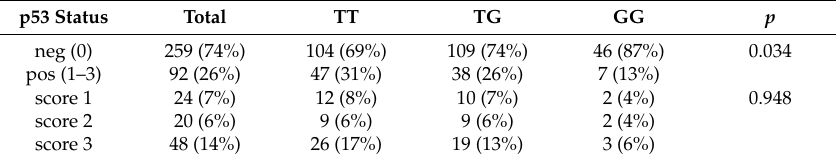
Table 4. Association of MDM2 SNP309 genotypes with p53 status.